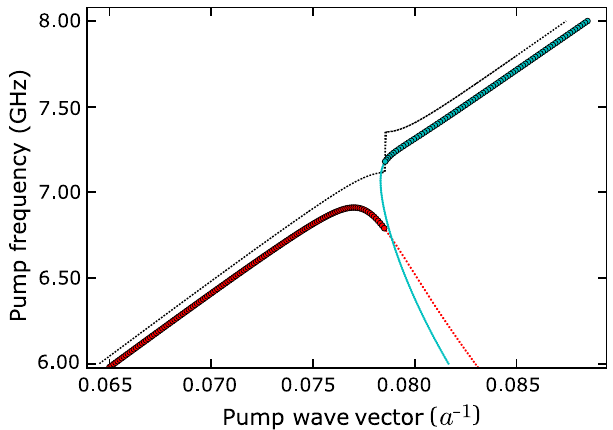
FIG. 7. Pump dispersion ω vs k in the linear case (dashed line) p and at − 71 -dBm incident power (symbols) determined by looking for solutions of Eqs. (A3a) – (A3e) for each pump frequency from 6 to 8 GHz. Thick symbols indicate the physical branches with P > 0 , thin symbols — unphysical branches with P < 0 . Note the existence of two physical solutions in a narrow interval of ω around 6.8 GHz. Investigation of their stability is p beyond the scope of this